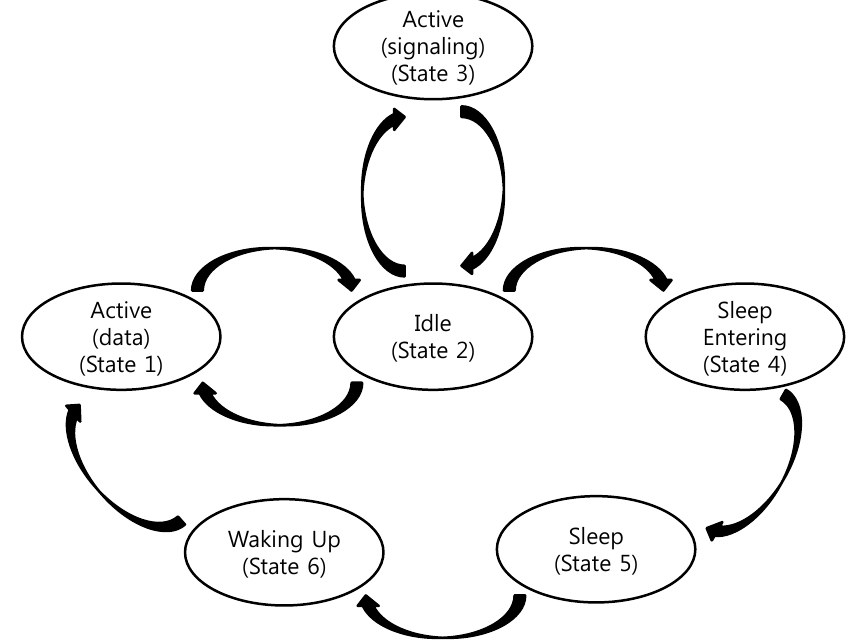
Figure 1. State transition model of the femto base